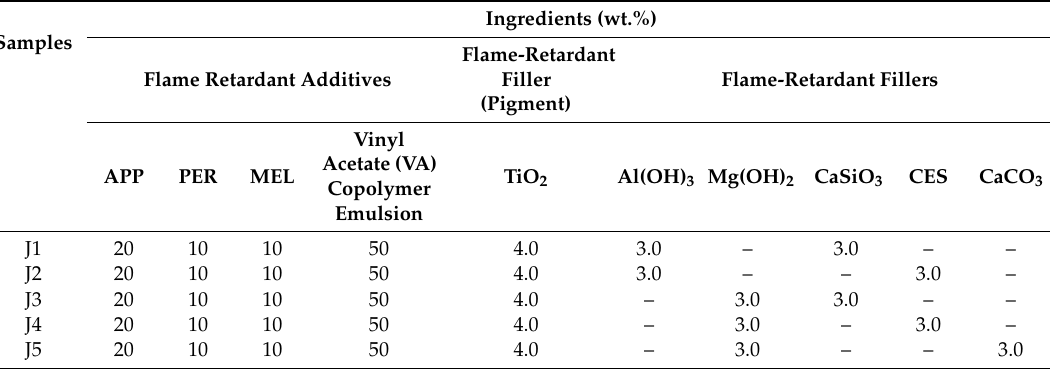
Table 1. Specifications of experimental materials.